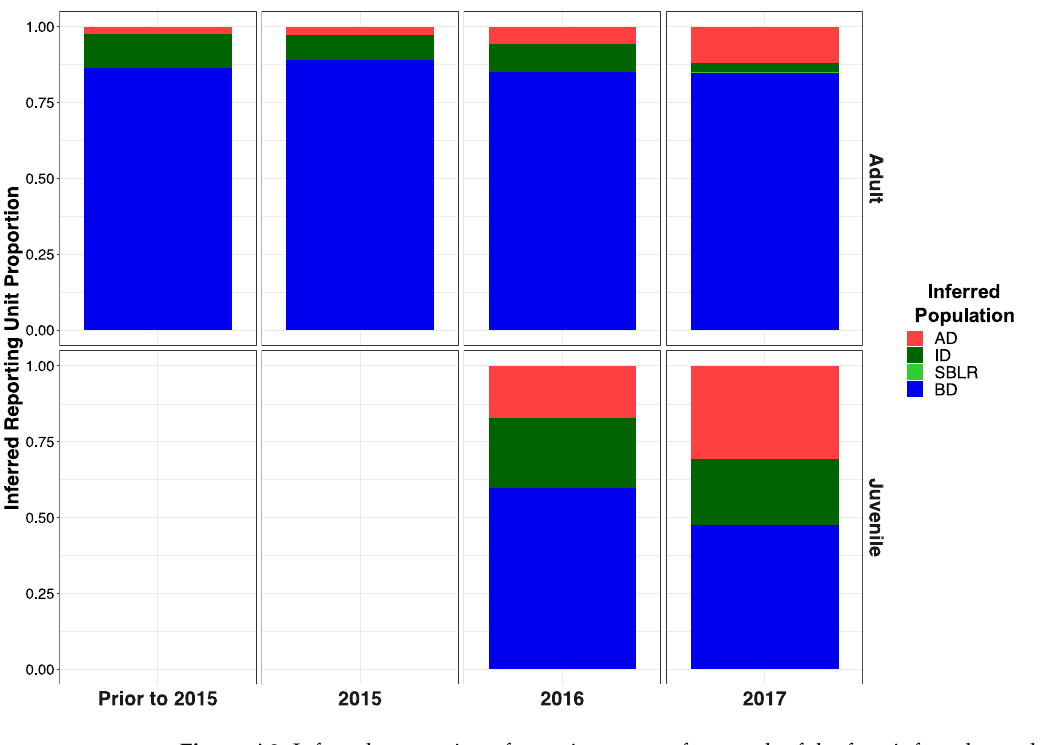
Figure A2. Inferred proportion of genetic ancestry from each of the four inferred populations across recolonizing adult and juvenile steelhead smolt life history cohorts from the GSI analysis (iii). Relative proportions of genetic ancestry from BD populations were greater in adult life history cohorts in GSI analysis (iii) compared to GSI analysis (i) GSI analysis (ii).